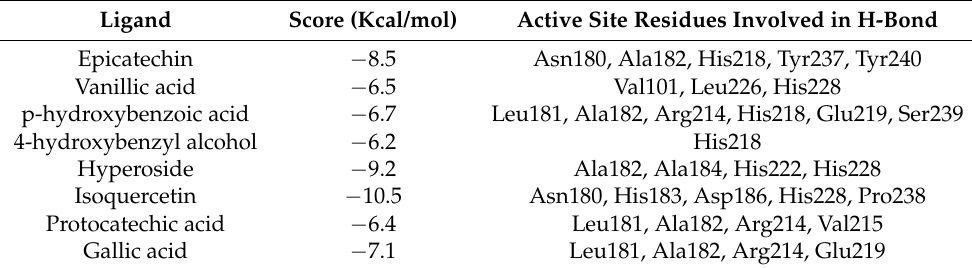
Table 4. Docking score and binding sites of the different ligands with collagenase.